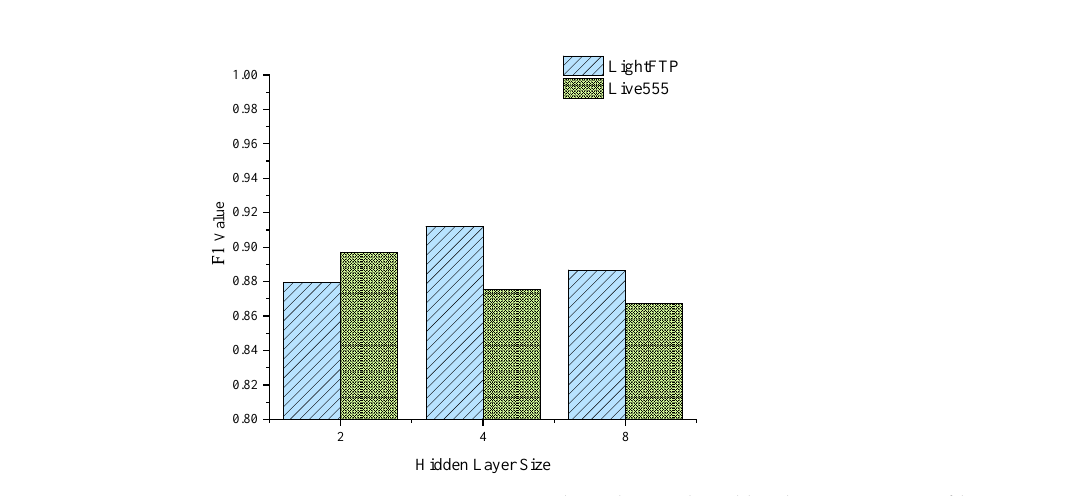
Figure 6. Comparative experimental results produced by the two test case filters.